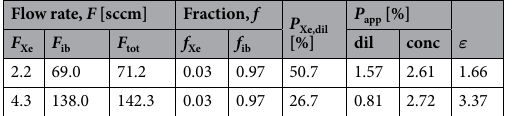
Table 2. Effect of the total gas flow rate on P Xe , P app , and ε using 3% Xe/97% isobutene